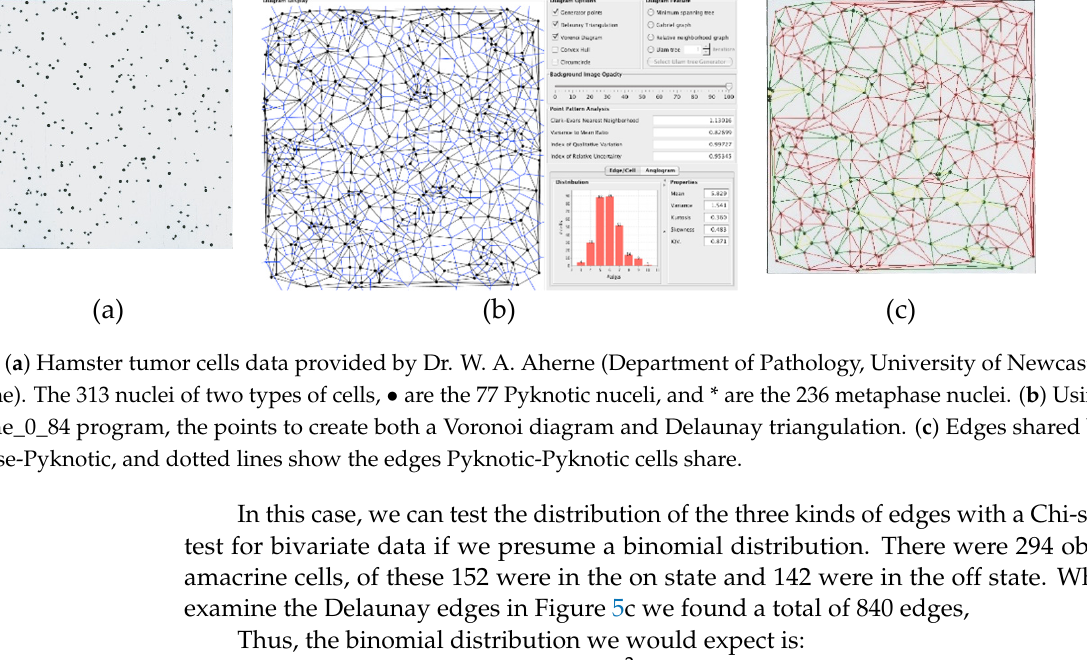
Figure 8. ( a ) Observed distribution of amacrine cells. ( b ) Ka-me screenshot of the distribution of Voronoi polygons generated by using each amacrine cell as a generator point. ( c ) A colored Delaunay triangulation of neighboring amacrine cells. There are three kinds of edges depending upon the corresponding states of neighboring amacrine cells: on-on, off-off, and on-off.